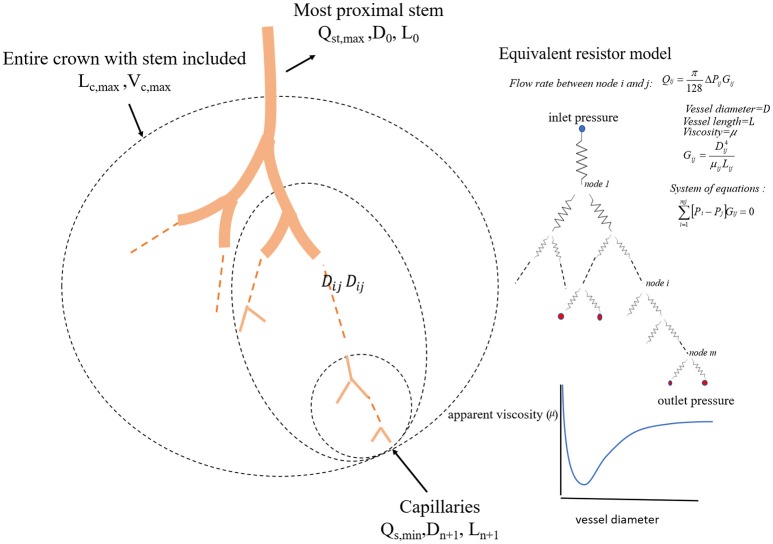
A schematic illustration of the definition of stem-crown units and the equivalent resistor model. The corresponding parameters. D, L, Q, and V are the diameter, length, flow rate, and volume, respectively. Subscriptst' “s” and “c” corresponding to stem and crown, respectively, in a stem-crown unit and subscripts “max” represent the most proximal stem-crown unit in a vascular tree.